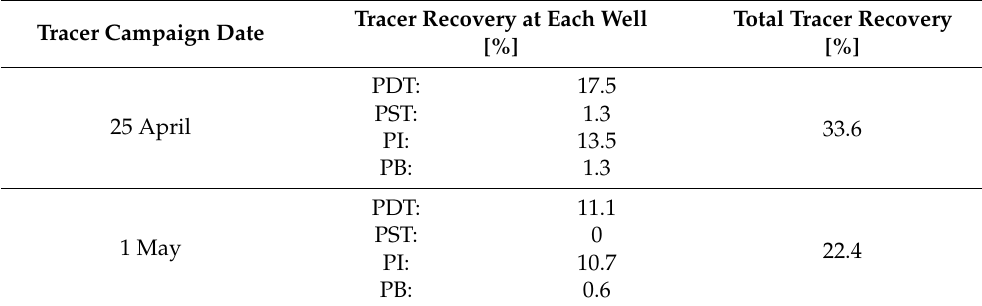
Figure 2. Breakthrough curves (BTCs) of each producing well in the conservative tracer test conducted on ( a , e ) 25 April, ( b , f ) 1 May, ( c , g ) 24 July, and ( d , h ) 22 October 2019, respectively, plotted against cumulative volume recovered ( a – d ) and against elapsed time since the start of tracer injection ( e – h ). Table 1. Summary of single-well tracer mass recoveries and the total recoveries in each tracer test